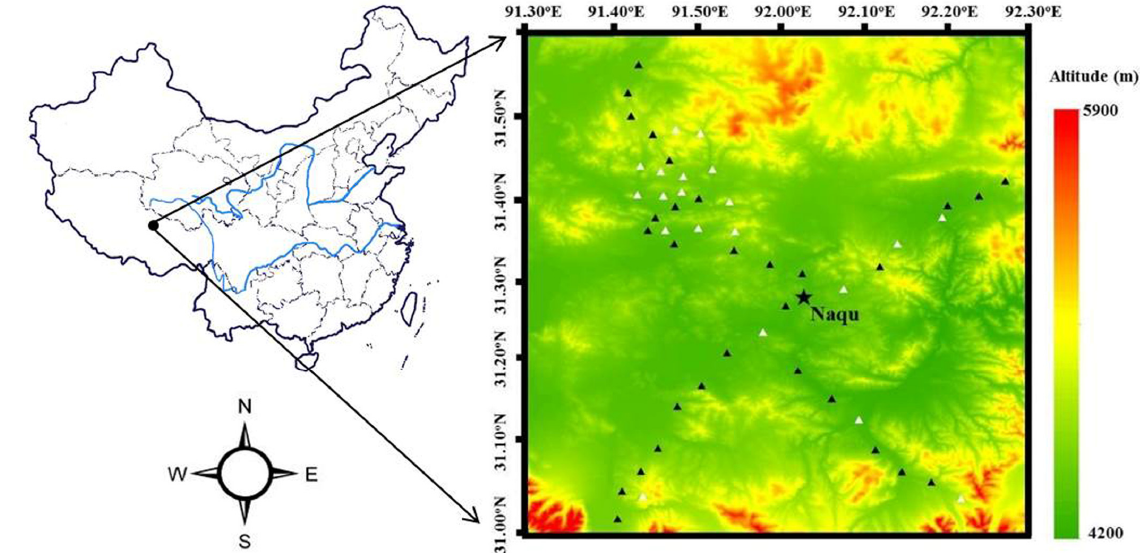
Figure 3. Location of the study area and a sketch map of the Soil Moisture/Temperature Monitoring Network (SMTMN) site distribution. The black triangles represent the first 30 sites built in 2010 and the white triangles denote the 20 sites setup in 2011. The black pentagram shows the location of Naqu